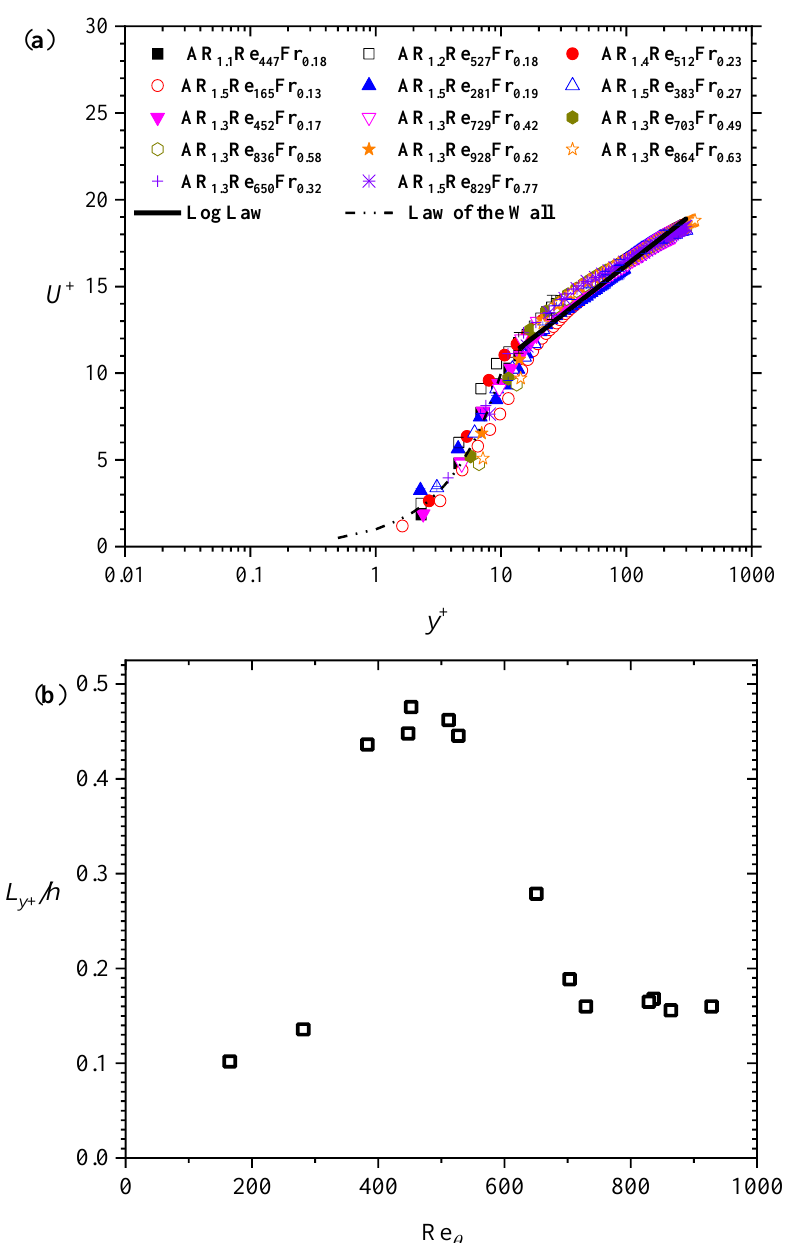
Figure 5. ( a ) Logarithmic plots of streamwise velocities using inner wall coordinates, along with the law of the wall, and the log law (Equations (1) and (2), respectively, for AR 1.2 Re 527 Fr 0.18 ). ( b ) The de- pendence of the log layer wall-normal range ( L y+ ) normalized by the flow depth h on the momentum thickness Reynolds number ( Re θ